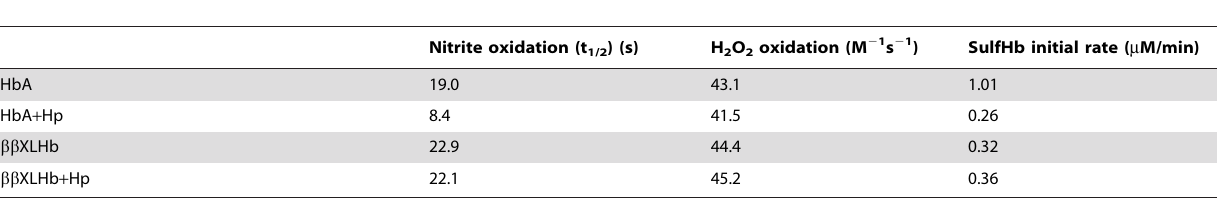
Table 2. Hb redox reaction parameters in the presence and absence of Hp.